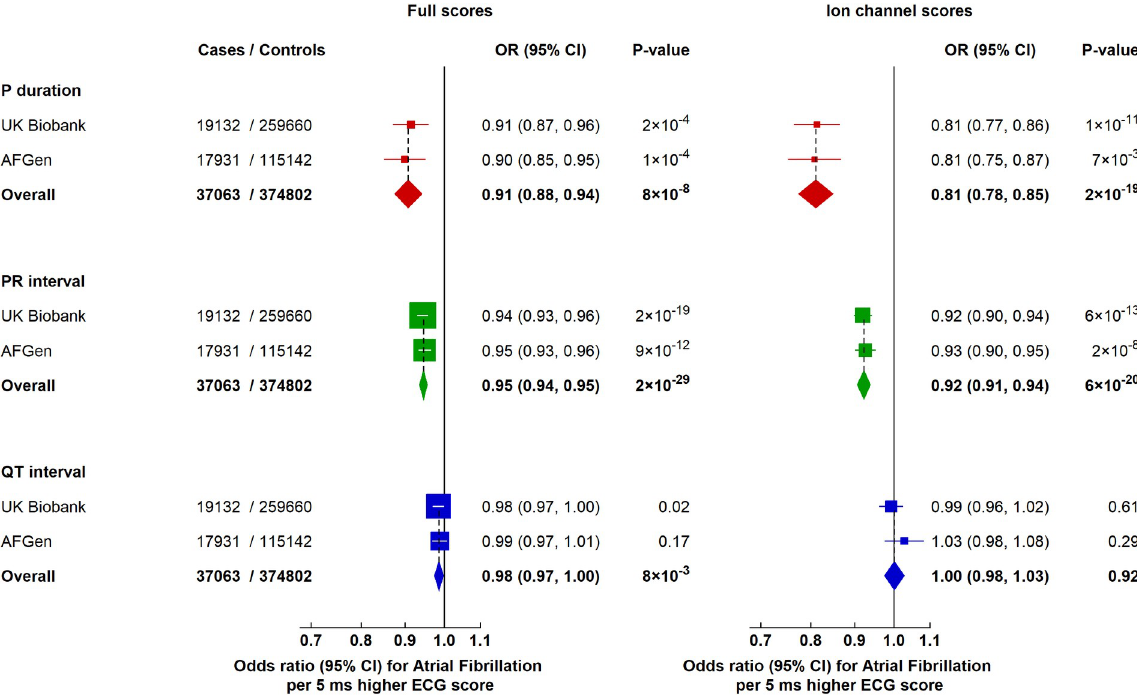
Fig 4. Effects of genetically predicted ECG parameters on risk of AF in UK Biobank and AFGen. Ion channel scores for each ECG parameter include only genetic variants annotated to known ion channel genes. Boxes represent point estimates of effect per 5 ms higher ECG score, diamonds represent meta-analysis estimates, with sizes inversely proportional to their variance, and lines represent 95% CIs. UK Biobank derived ORs are adjusted for sex, genotyping array, and 40 principal components of ancestry. ORs for AFGen were calculated using inverse variance weighted fixed-effects methods from published summary data. AF, atrial fibrillation; CI, confidence interval; ECG, electrocardiographic; OR, odds ratio.